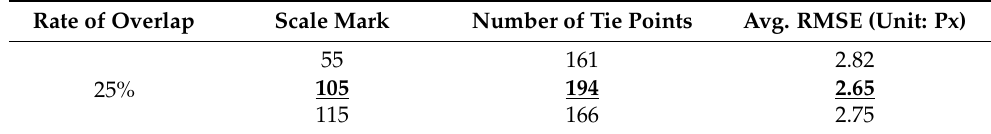
Figure 5. Visualizing the stitched errors for 25% of overlap with different scale marks. ( A ) Stitched image and area of interest (red part) for comparison; ( B ) Zoom-in ( A )’s red part with the case of scale mark 10; ( C ) Zoom-in ( A )’s red part with the case of scale mark 55; ( D ) Zoom-in ( A )’s red part with the case of scale mark 105. Table 3. Comparison between number of tie points and avg. RMSEs with different scale